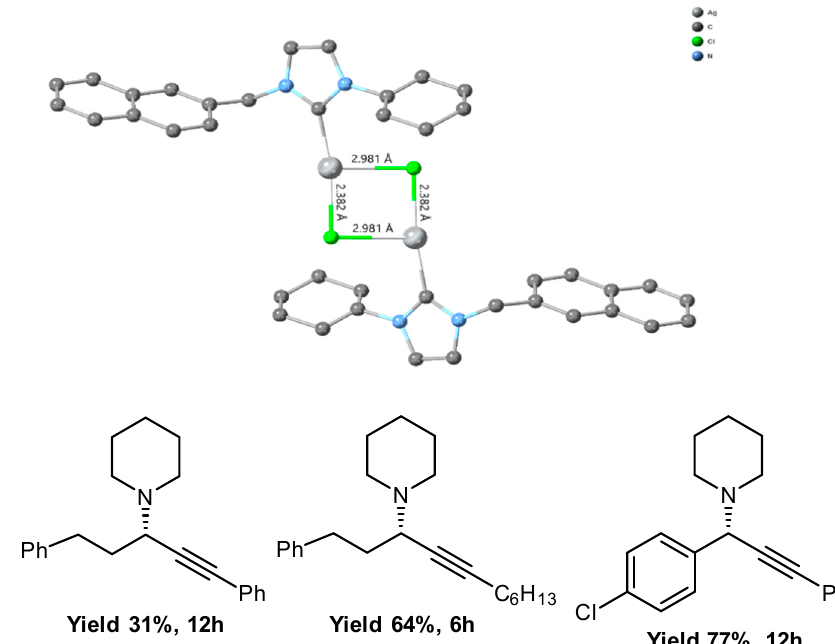
Scheme 55. ( upper ) The crystallographically characterised N-heterocyclic carbene-Ag(I) halides of 1-cyclohexyl-3-arylmethylimidazolylidenes pre-catalyst. ( lower ) Selected PA examples. A year later, Sun et al. [114] reported the synthesis and characterisation of a one- dimensional zig zag coordination polymer built from 1,4-bis(4,5-dihydro-2- oxazolyl)benzene (bdob) and Ag(I) nitrate and formulated [Ag(NO 3 )(bdob)] ( 3 , Scheme 56). Compound 3 was found to promote the A 3 coupling reaction in the open air at 1.9% catalyst loading and room temperature in the absence of additives. The authors identified the scope and limitations of their approach. The method applies to a good range of alkynes, aldehydes and amines; however, reactions with primary amines and aromatic